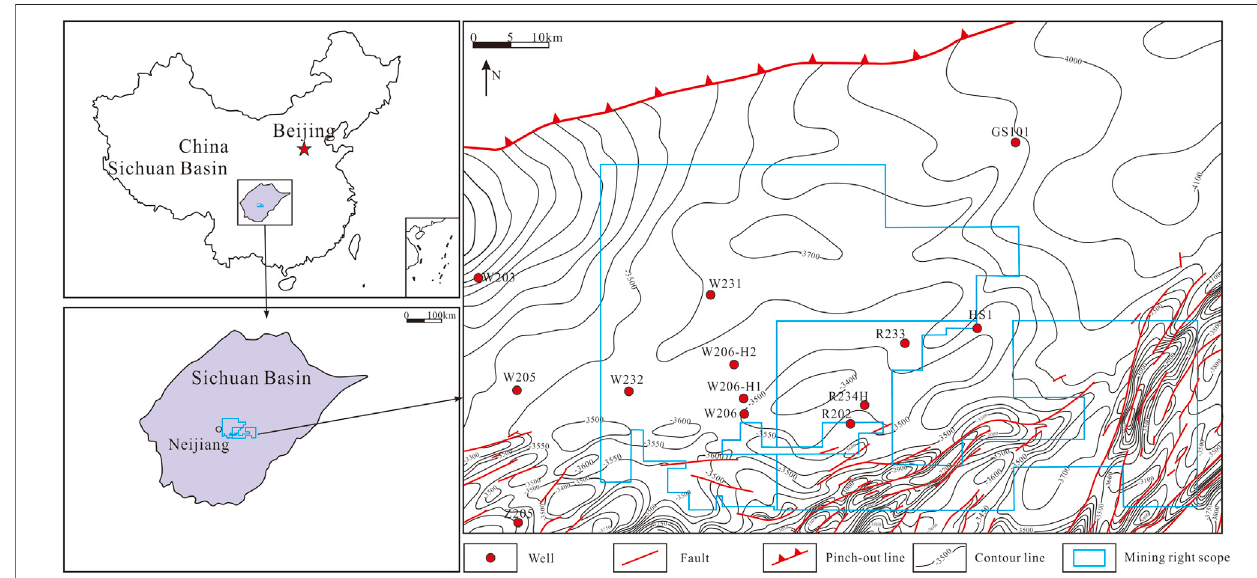
FIGURE 1 | Seismic re fl ection structure of the Upper Ordovician top boundary in the study area.